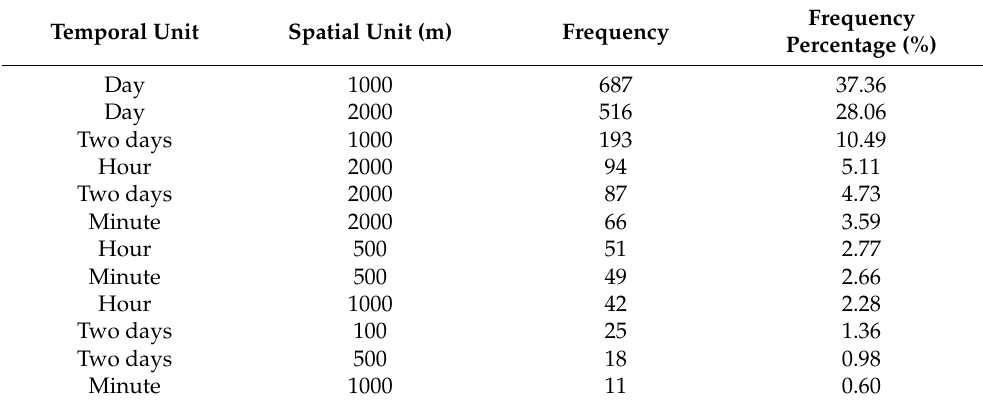
Table 4. Distribution of optimal spatiotemporal analysis units based on resampling1600 times. Temporal Unit Spatial Unit